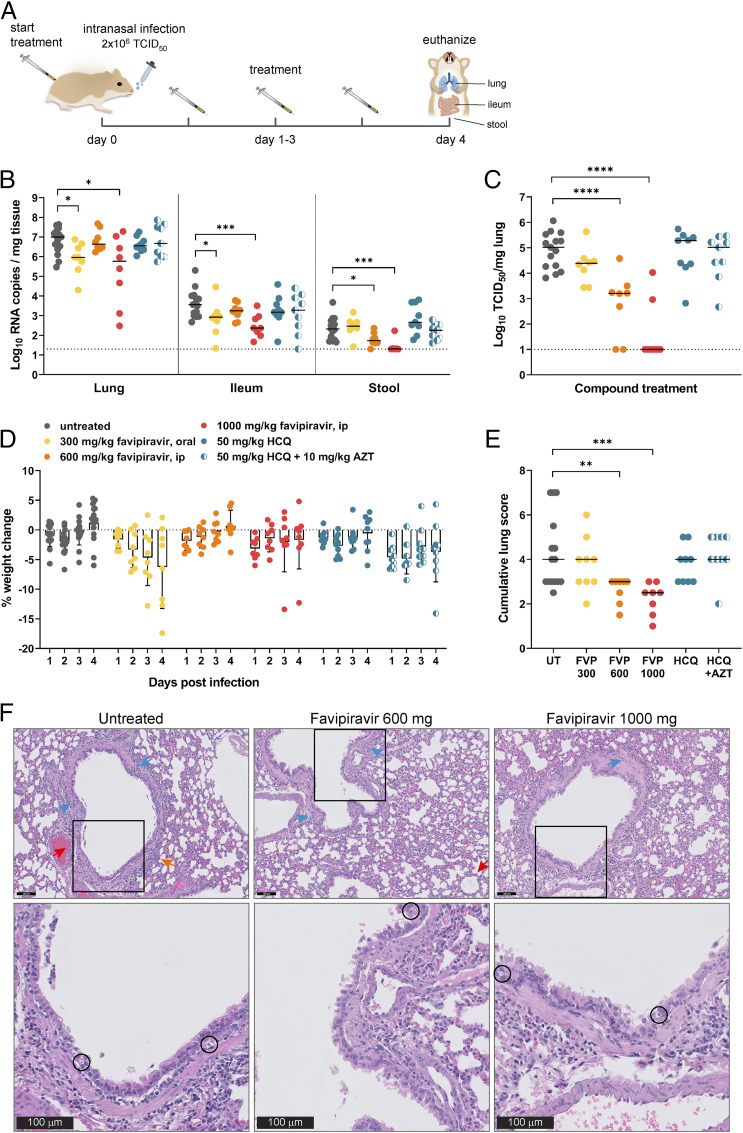
In vivo testing of favipiravir and HCQ in the SARS-CoV-2 infection model. (A) Setup of the study. (B) Viral RNA levels in the lungs, ileum, and stool of untreated and treated (favipiravir, HCQ, or HCQ + azithromycin) SARS-CoV-2−infected hamsters at day 4 pi. At the indicated time intervals pi, viral RNA levels were quantified by RT-qPCR. The bars represent median values. (C) Infectious viral load in the lung of untreated hamsters and hamsters receiving treatment (favipiravir, HCQ, or HCQ + azithromycin) expressed as TCID50 per milligram of lung tissue obtained at day 4 pi. The bars represent median values. (D) Weight change of individual hamsters (dots) as compared to the weight at day 0 in percentage points at the indicated time intervals pi. Bars represent means ± SD. (E) Cumulative severity score from H&E stained slides of lungs from SARS-CoV-2−infected hamsters that were untreated (UT, gray) or treated with favipiravir 300 mg/kg (FVP 300, yellow), 600 mg/kg (FVP 600, orange), 1,000 mg/kg (FVP 1000, red), HCQ (blue), or HCQ + azithromycin (blue-white). The bars represent median values. (F) Representative H&E images of lungs at day 4 pi of SARS-CoV-2−infected hamsters and treated with favipiravir. At day 4, lungs of untreated hamsters show significant inflammation in bronchial wall (blue arrows) with apoptotic bodies in respiratory epithelium and extension into adjacent alveoli (orange arrow) and inflammatory cells in arterial wall (red arrow). Lungs of infected hamsters treated with 600 mg⋅kg−1⋅d−1 favipiravir still show a few inflammatory cells in the bronchial wall (blue arrows) and a few focal perivascular lymphocytes (red arrow), whereas lungs of hamsters treated with 1,000 mg⋅kg−1⋅d−1 favipiravir contain even less inflammatory cells in the bronchial wall, but no perivascular inflammation. Apoptotic bodies (black circles) were present in bronchial walls of hamsters from all three groups (Scale bars, 100 µm.) Data were analyzed with the Mann−Whitney U test. *P < 0.05; **P < 0.01; ***P < 0.001; ****P < 0.0001.